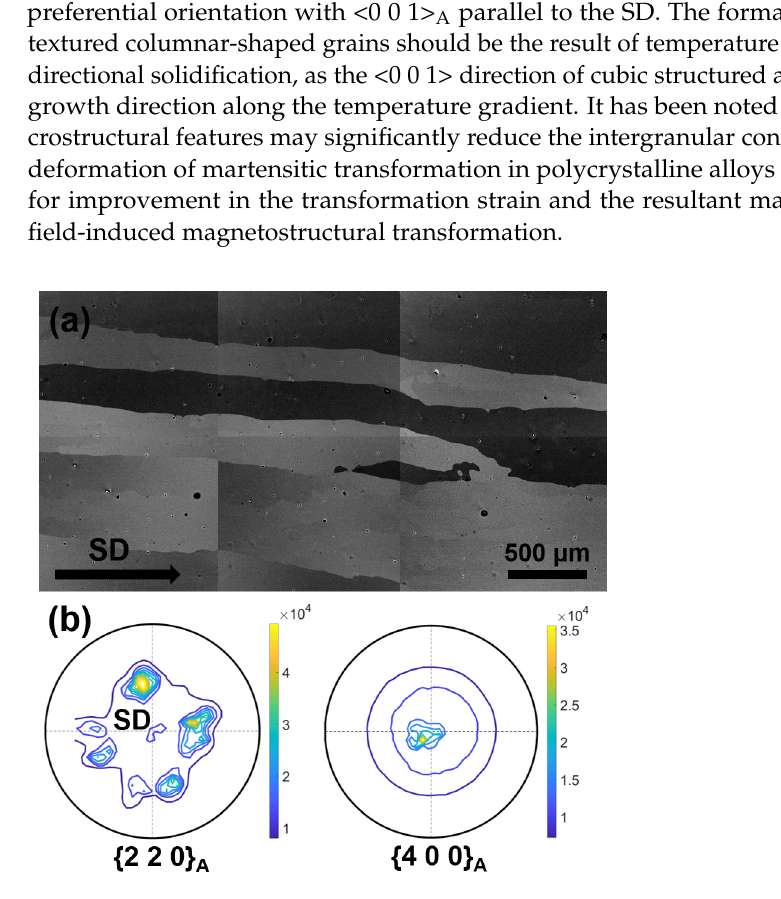
Figure 3. ( a ) Microstructural image of the longitudinal section of the directionally solidified Ni 44.5 Co 4.9 Mn 37.5 In 13.1 alloy at room temperature. ( b ) {2 2 0} A and {4 0 0} A incomplete pole figures con- structed by XRD measurements on the transverse section of the directionally solidified alloy at room temperature. The center of pole figure corresponds to the SD.